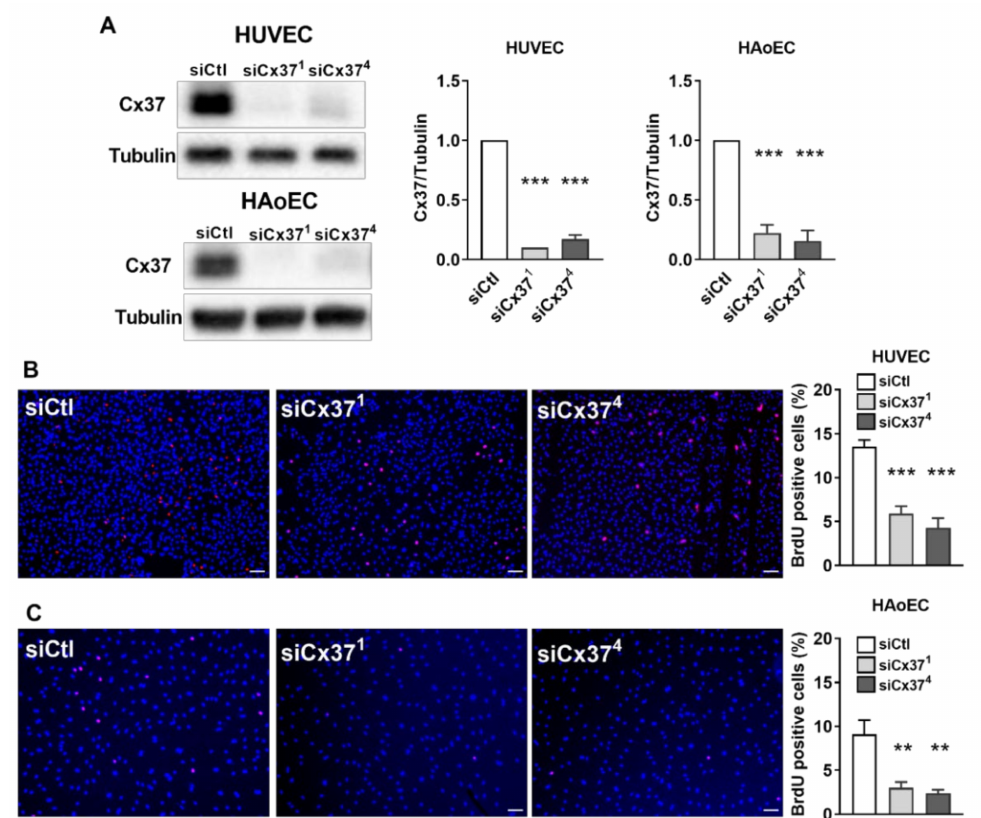
Figure 2. In vitro targeting Cx37 reduces the proliferation of primary EC. ( A ) Western blot of primary human vein (HUVEC) and aortic EC (HAoEC) revealed that Cx37 expression was reduced by 80–90% 48 h after transfection with either siCx37 1 or siCx37 4 , two siRNAs targeting Cx37. Such a drastic change was not observed when the cells were transfected with a control siRNA (siCtl). Graphs show mean + SEM, *** p < 0.001 versus siCtl (one-way ANOVA followed by Tukey’s post-test). ( B , C ) As judged by the incorporation of BrdU (red) in the nuclei (stained in blue by DAPI), the proliferation of the HUVEC and HAoEC that had lost most of Cx37 was decreased to about 30% of control levels. Graphs show mean values + SEM, n = 8 separate experiments, each performed in duplicate. ** p < 0.01, *** p < 0.001 vs. siCtl (one-way ANOVA followed by Tukey’s post-test). Scale bars = 50 µ